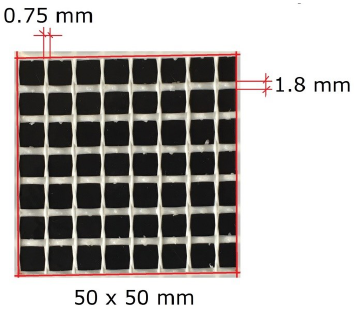
Figure 13: The total area of the gaps is equal to 1710 mm 2 (for 205 g/m 2 the fibreglass mesh)